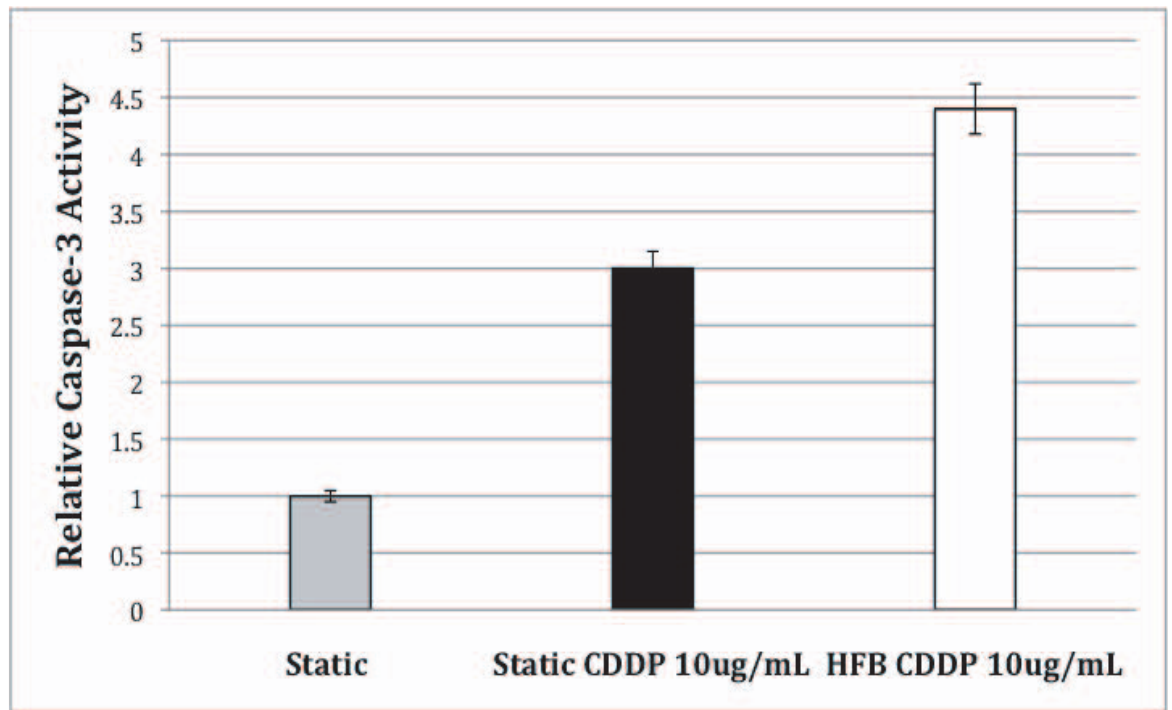
Figure 10. Graphic representation of the relative caspase-3 activity of SAOS-2 cells exposed to CDDP after growth stimulation in simulated hypogravity. SAOS-2 cells grown for 5 days in the hydrofocusing bioreactor and treated with 10 m g/mL of CDDP die by apoptosis as evidenced by a caspases-3 colorimetric assay. The white bar illustrates the caspase-3 activity recovered from SAOS-2 cells grown in the HFB and then treated with CDDP for 24-hours. The black bar illustrates the caspase-3 activity recovered from SAOS-2 cells grown in static normal (1-G) condition and then treated with CDDP for 24-hours, and the grey bar indicates the basal caspases-3 activity of SAOS-2 cells grown in static 1-G condition.